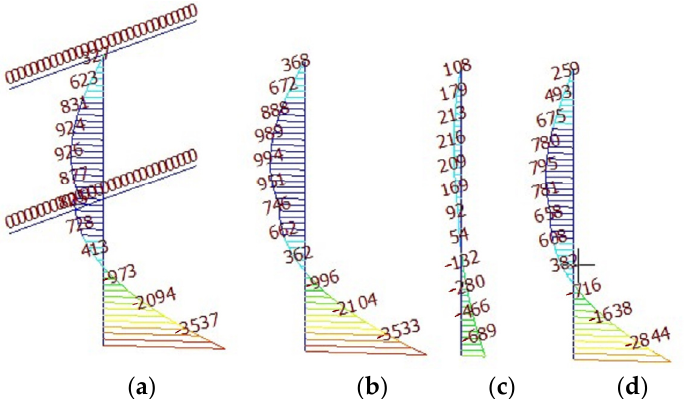
Figure 13. Bending moment diagram of wall column under two-dimensional simulation model (unit: kN·m). ( a ) Bending moment diagram of the model of Figure 12a; ( b ) Bending moment diagram of the model of Figure 12b; ( c ) Bending moment diagram of the model of Figure 12c; ( d ) Bending moment diagram of the model of Figure 12d.